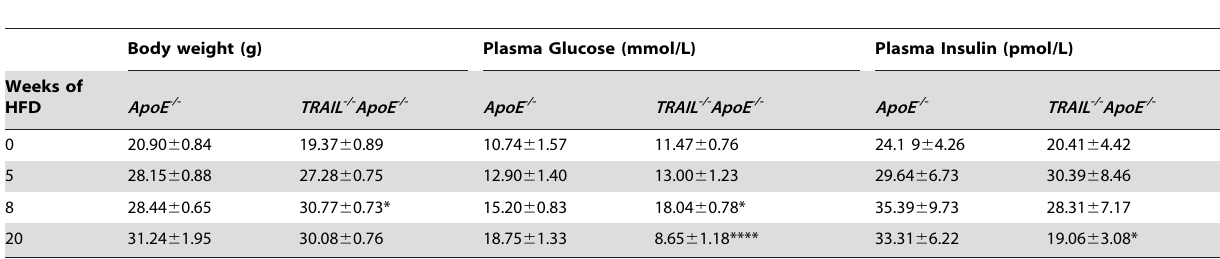
Table 3. Body weights, plasma glucose and insulin levels in HFD-fed ApoE -/- and TRAIL -/- ApoE -/- mice.